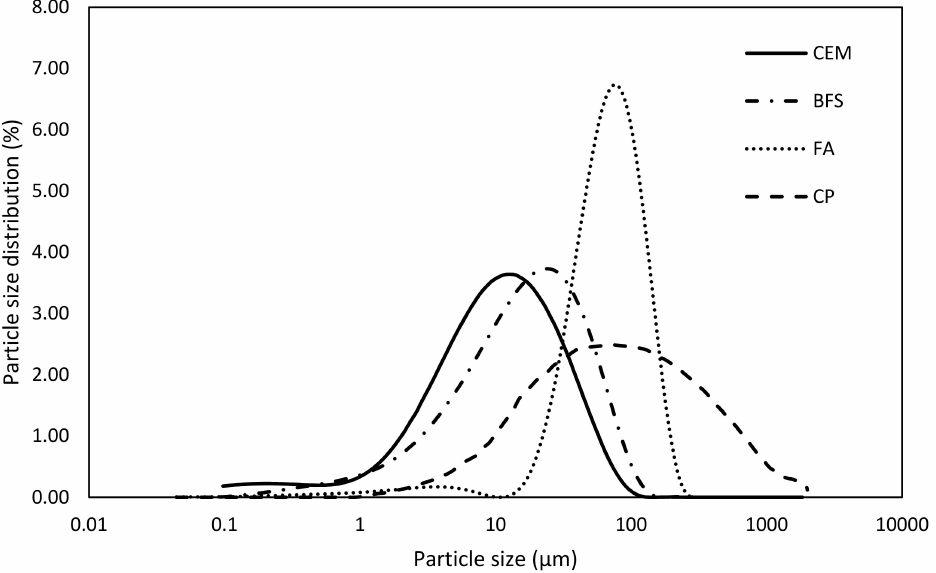
Figure 2. Particle size distribution of studied mineral